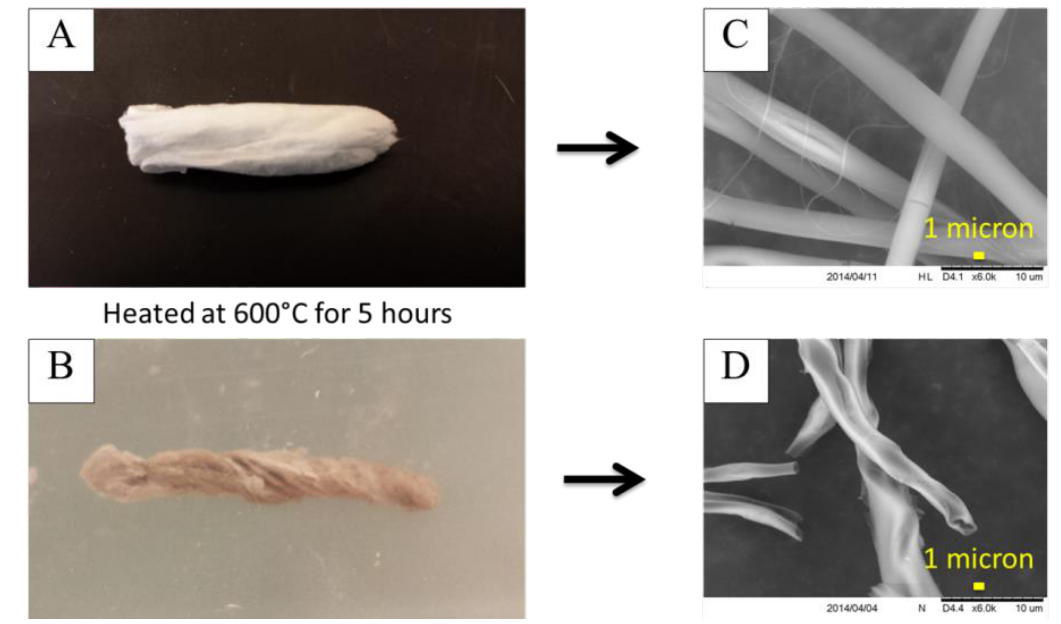
Figure 4. Rolled fiber bundle ( A ) before and ( B ) after calcination at 600 °C for 5 h and SEM images ( C ) before and ( D ) after to show the change in fiber structure. Image ( D ) shows the ends of several of the fibers and the hollow cores are